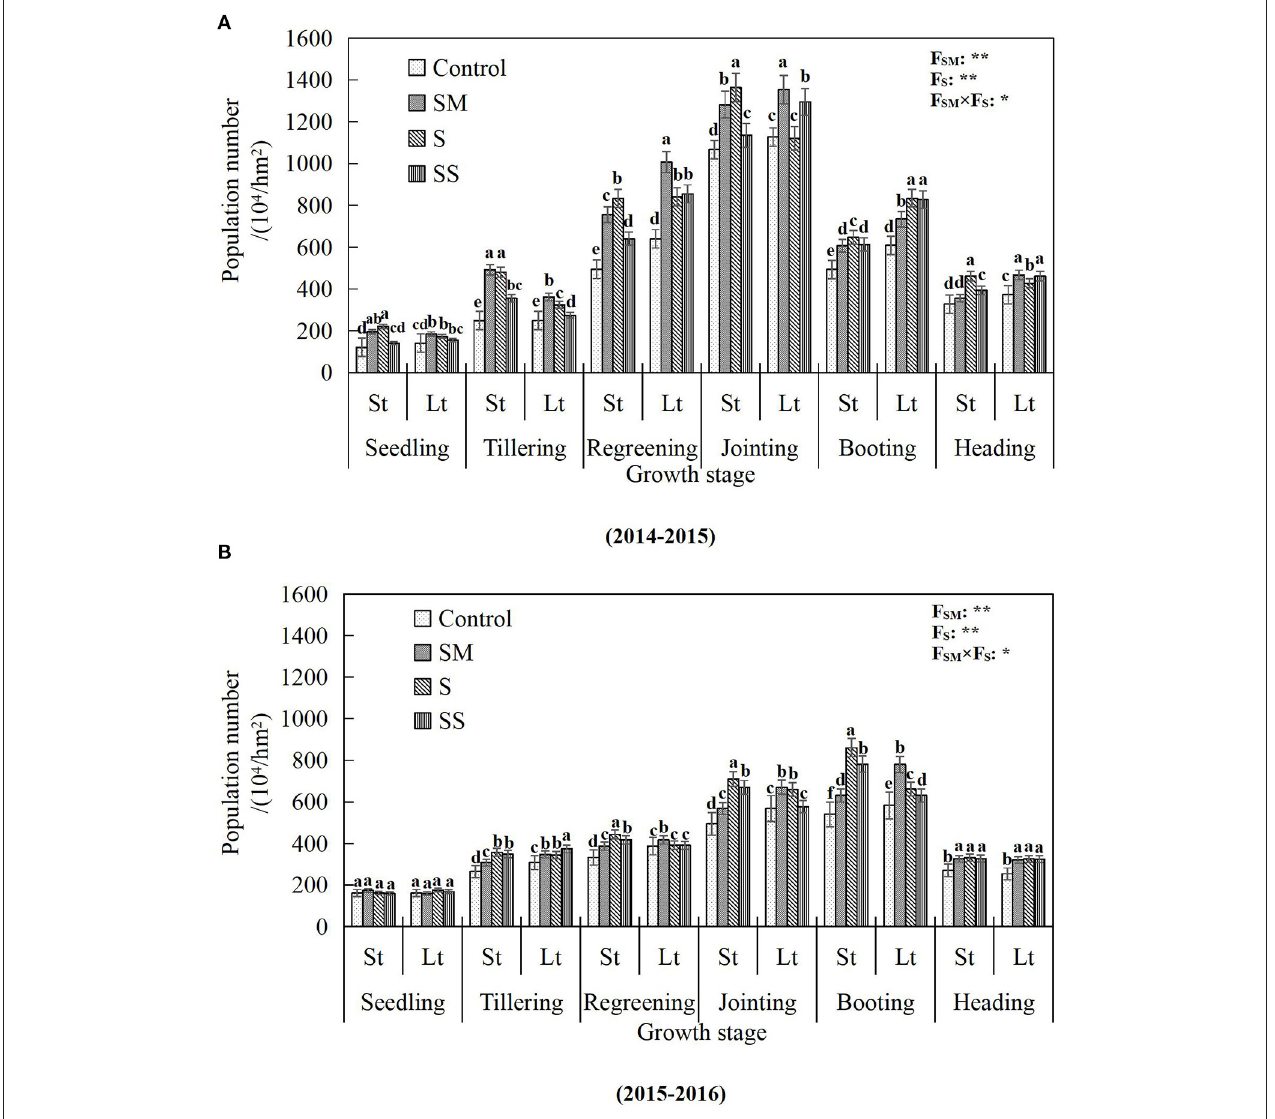
FIGURE 2 | Population number in different growth stages of wheat under the Control, SM, S and SS treatments in different years. Error bars represent standard deviation ( n = 3). Columns labeled with different letters represent significant differences at P < 0.05 among treatments of two experiments at same growth stage. (A) 2014962015 and (B) 2015962016. St, short-term; Lt, long-term; Control, conventional tillage; SM, straw mulching; S, subsoiling; SS, subsoiling + straw mulching. F SM , F S and F SM × F S mean F-values of straw mulching, subsoiling and their interactions in variance analysis respectively. “* and **” indicate difference at the 0.05 and 0.01 levels, respectively.